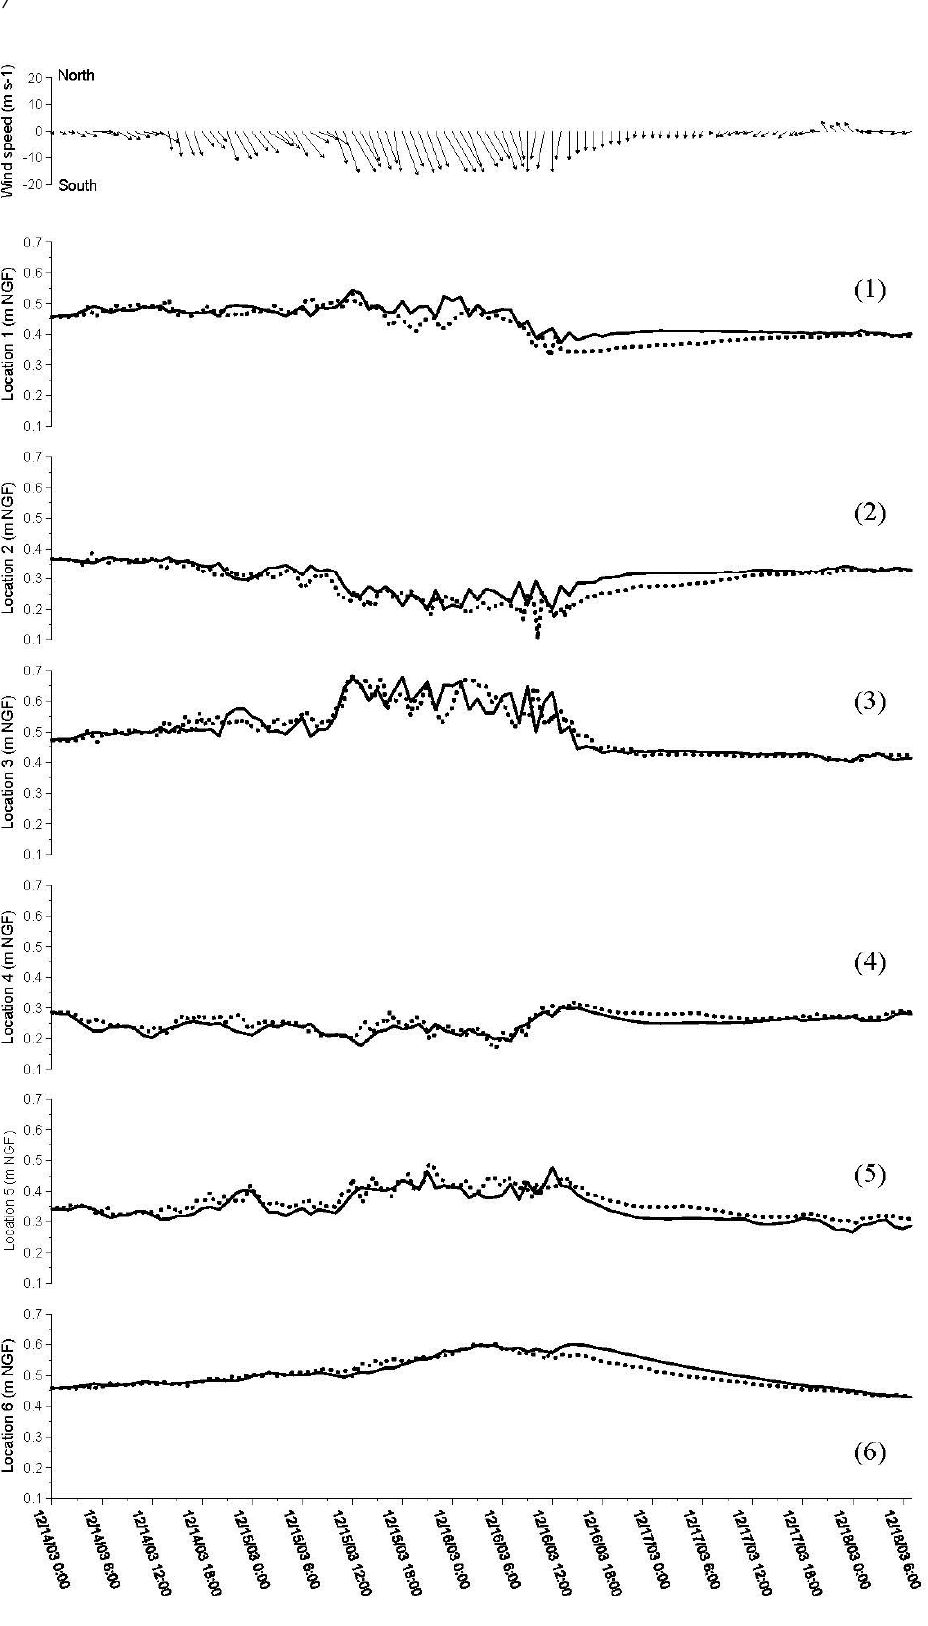
Figure 7. Measured wind vectors at the meteorological station B, measured and modeled water levels at locations one to six (see Figure 1) from 14 December to 18 December 2003. Modeled water levels are shown with solid lines and measured water levels with dotted lines. Measured wind vectors at the meteorological station A are not represented for the sake of legibility of the